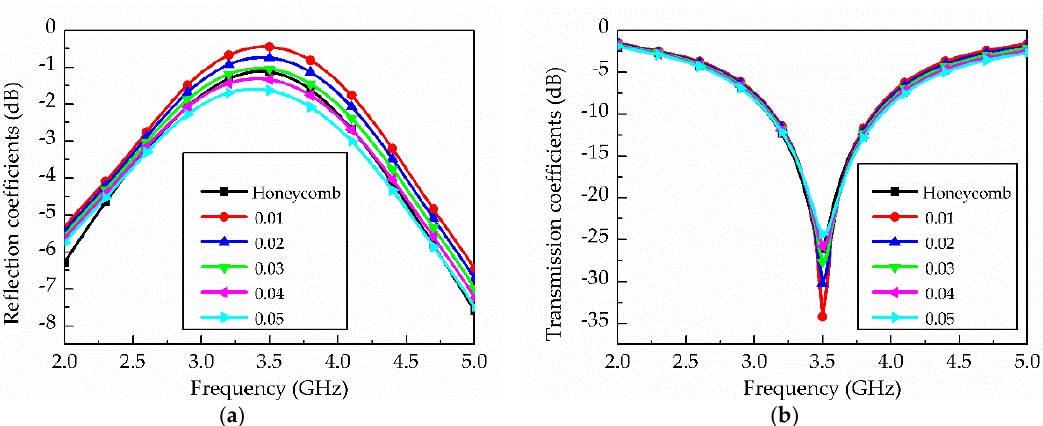
Figure 5. T ‐ resonator simulation results: ( a ) reflection and ( b ) transmission coefficients when tan δ is varied from 0.01 to 0.05.